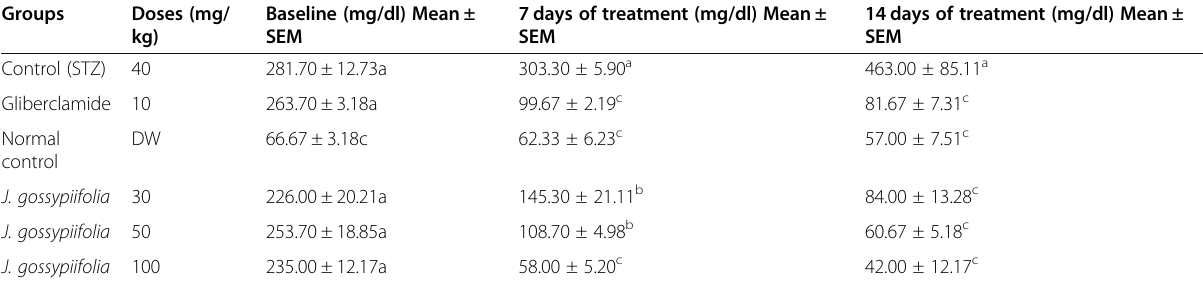
Table 3 Effect of J. gossypiifolia in blood sugar level